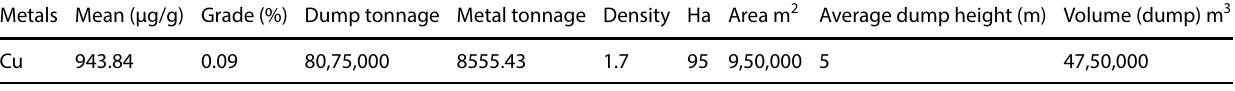
a ppm (µg/g)/10 000